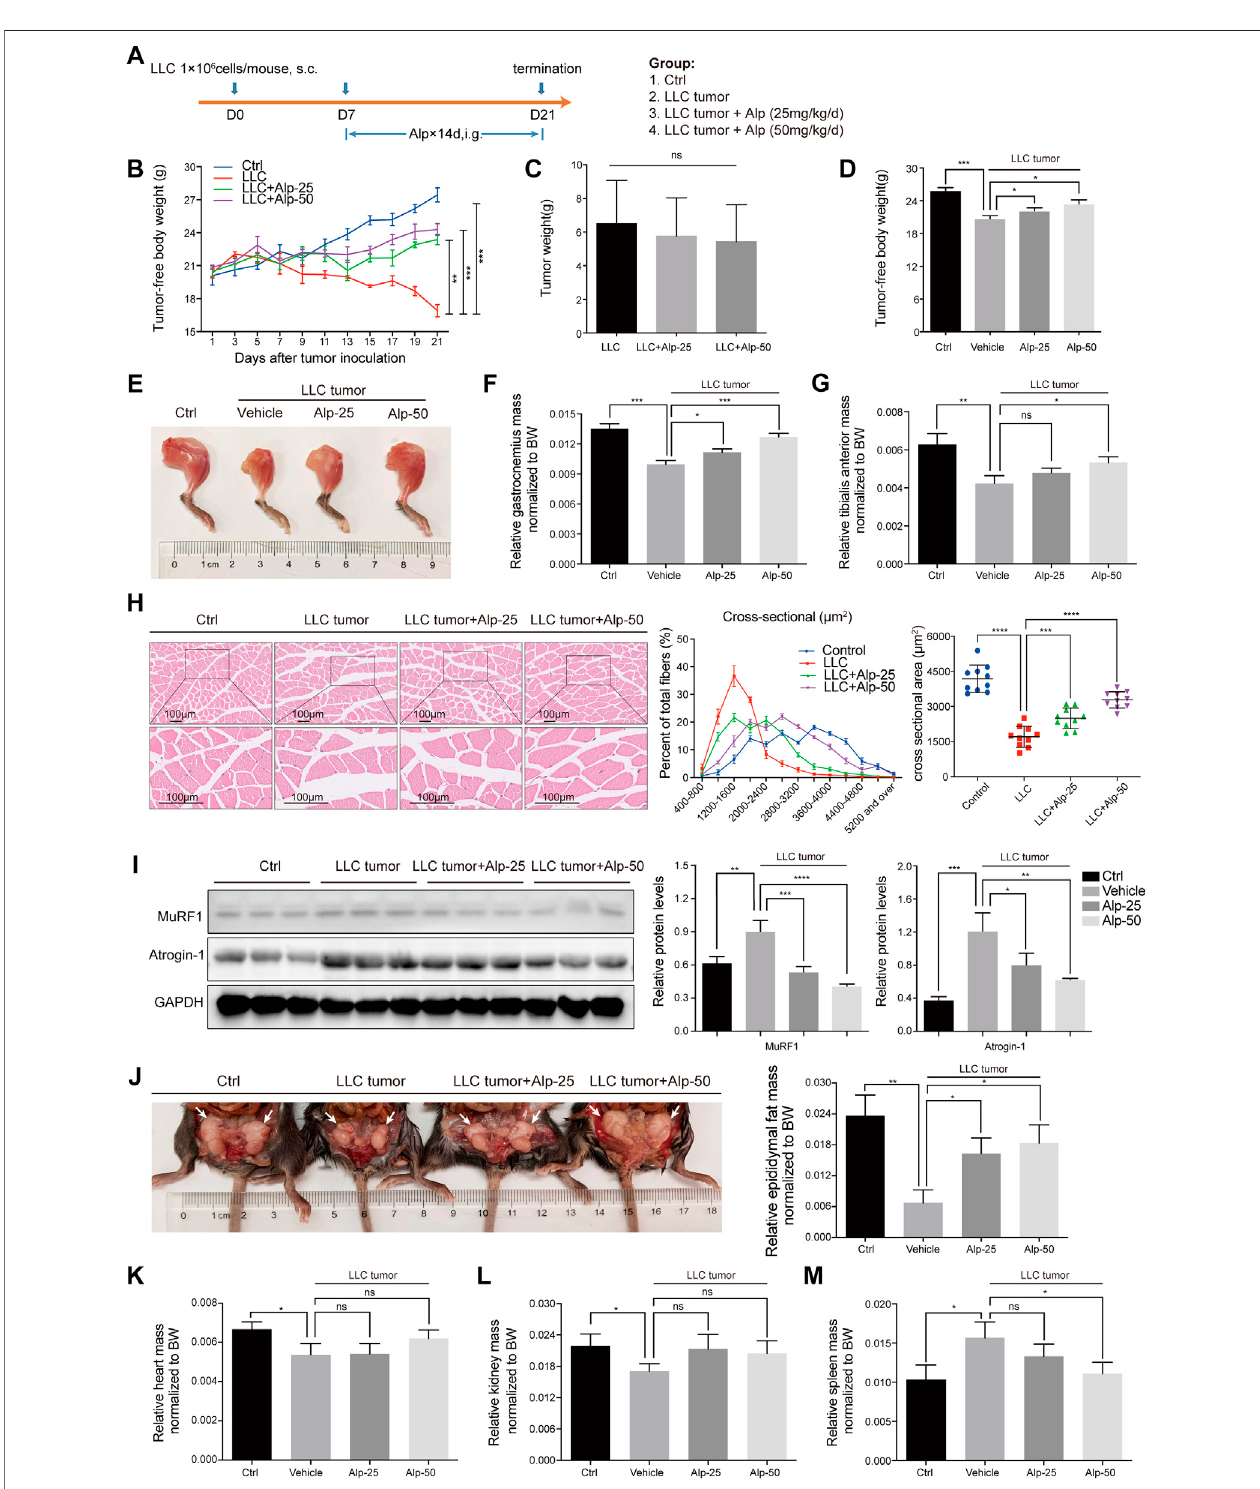
FIGURE2| Alppreventsweight lossandattenuatesmusclewasting inLLC tumor – bearingmice. (A) Schematicpresentation oftheanimalexperimentdesign. The effects of Alp on the main parameters of cachexia were observed, including (B – D) tumor-free body weight, (C) tumor weight, (E – G) gastrocnemius and tibialis anterior muscles mass, (J) epididymal fat mass, and (K – M) heart, kidney, and spleen mass (BW: body weight). (H) Gastrocnemius muscle was examined histologically by HE staining and cross-sectional area analysis. (I) Protein levels of Atrogin-1 and MuRF1 in gastrocnemius muscles were evaluated by Western blot, and the densities were calculated and normalized with GAPDH. * p < 0.05, ** p < 0.01, *** p < 0.001, **** p < 0.0001 vs. control. ns: not signi fi cant. n (cid:1) 10 mice/group.